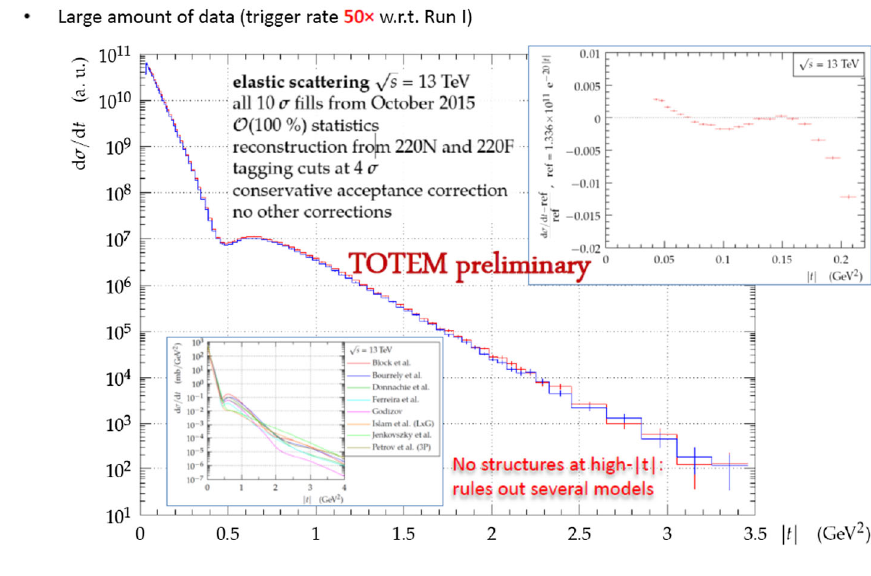
Fig. 1 The differential cross section of elastic scattering of protons at 13 TeV shown in [2] and discussed in [3,4]. The upright insert demonstrates slight oscillations within the diffraction cone. Another insert contains some theoretical predictions outside the diffraction